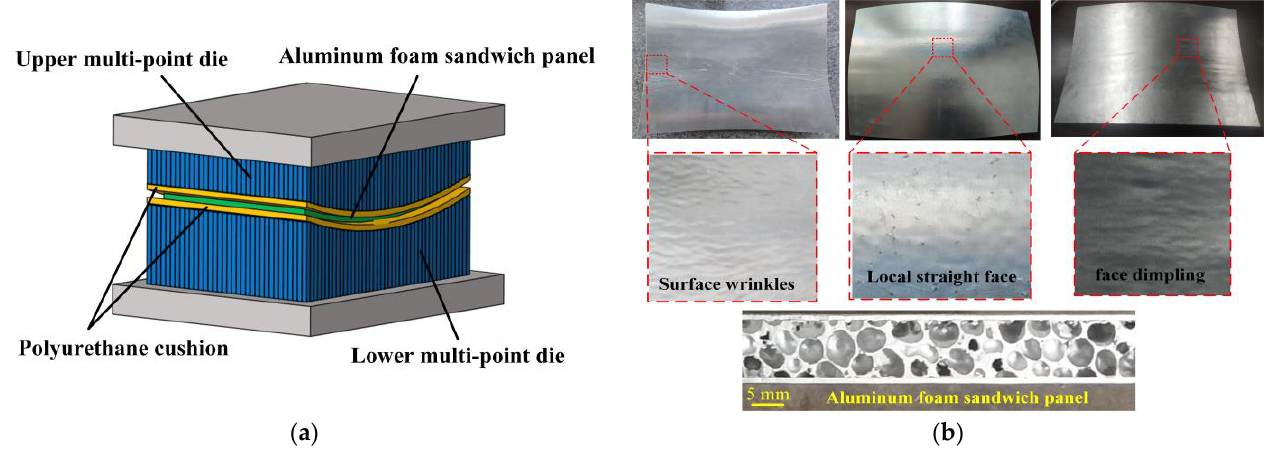
Figure 1. ( a ) Schematic diagram of MPF of AFSP ( b ) surface defects of AFSP.